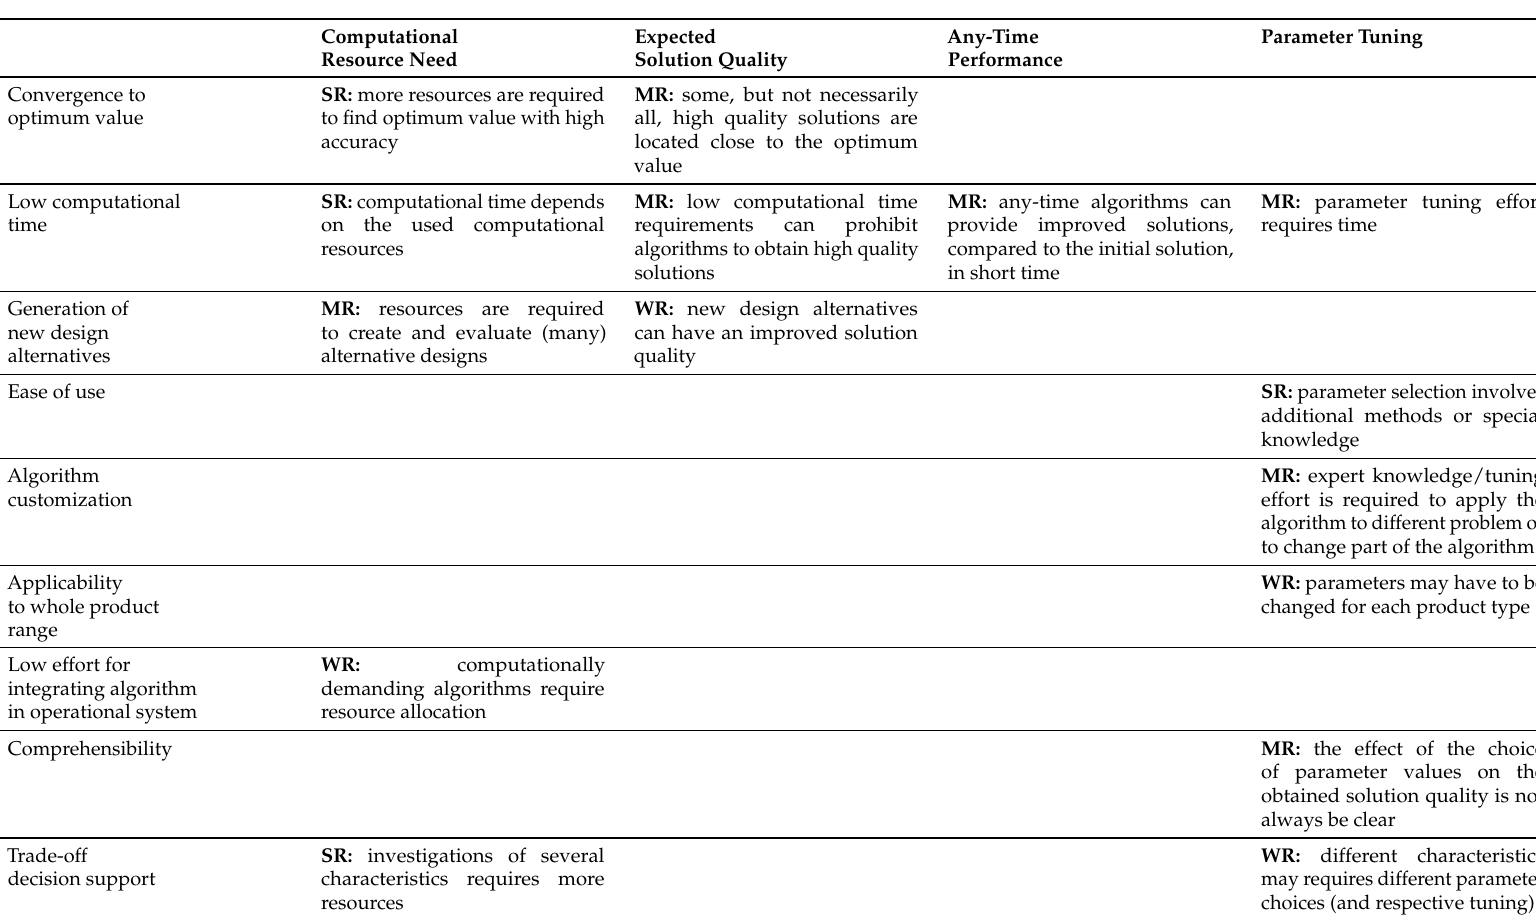
Table A3. Part 1 of relationships between end-user requirements and comparison criteria for the Decision Matrix. The used relationships are: SR , strong relationship; MR , moderate relationship; WR , weak